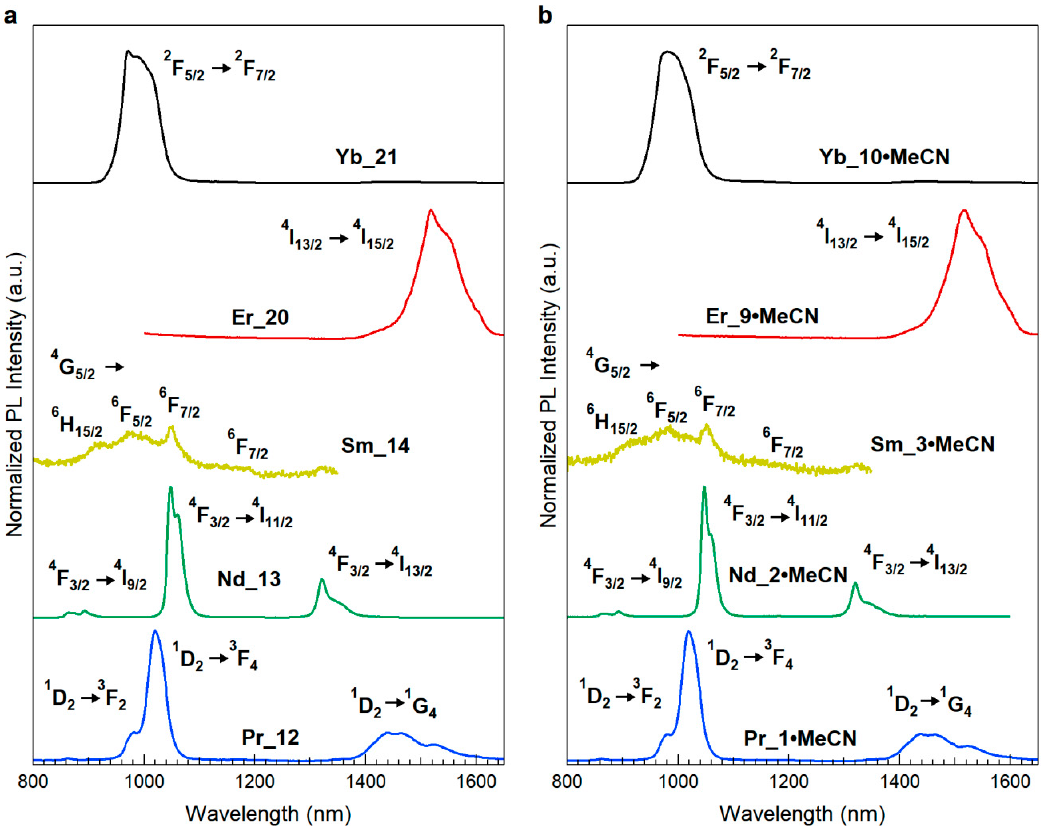
Figure 12. Solid-state, room-temperature near-IR emission spectra of complexes 1 ·MeCN_Pr, 2 ·MeCN_Nd, 3 ·MeCN_Sm, 9 ·MeCN_Er, and 10 ·MeCN_Yb (( b ), right) and 12 _Pr, 13 _Nd, 14 _Sm, 20 _Er, and 21 _Yb (( a ), left).